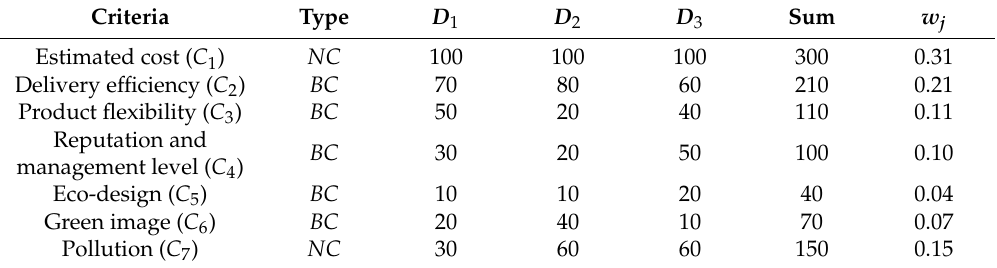
Table 2. Determination of the criteria weights using